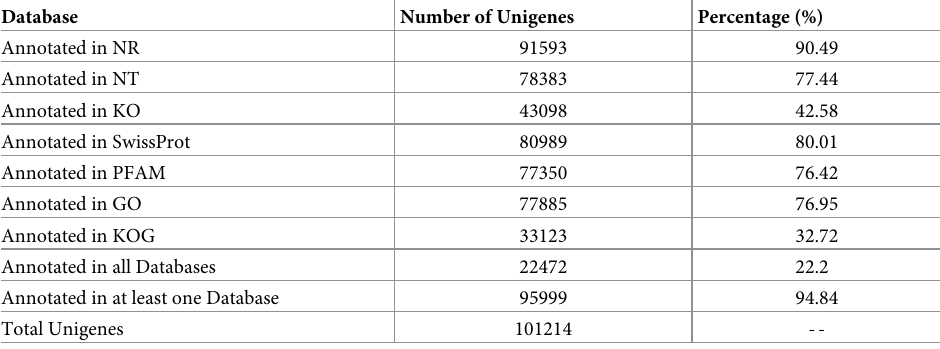
Table 2. The success rate of unigene